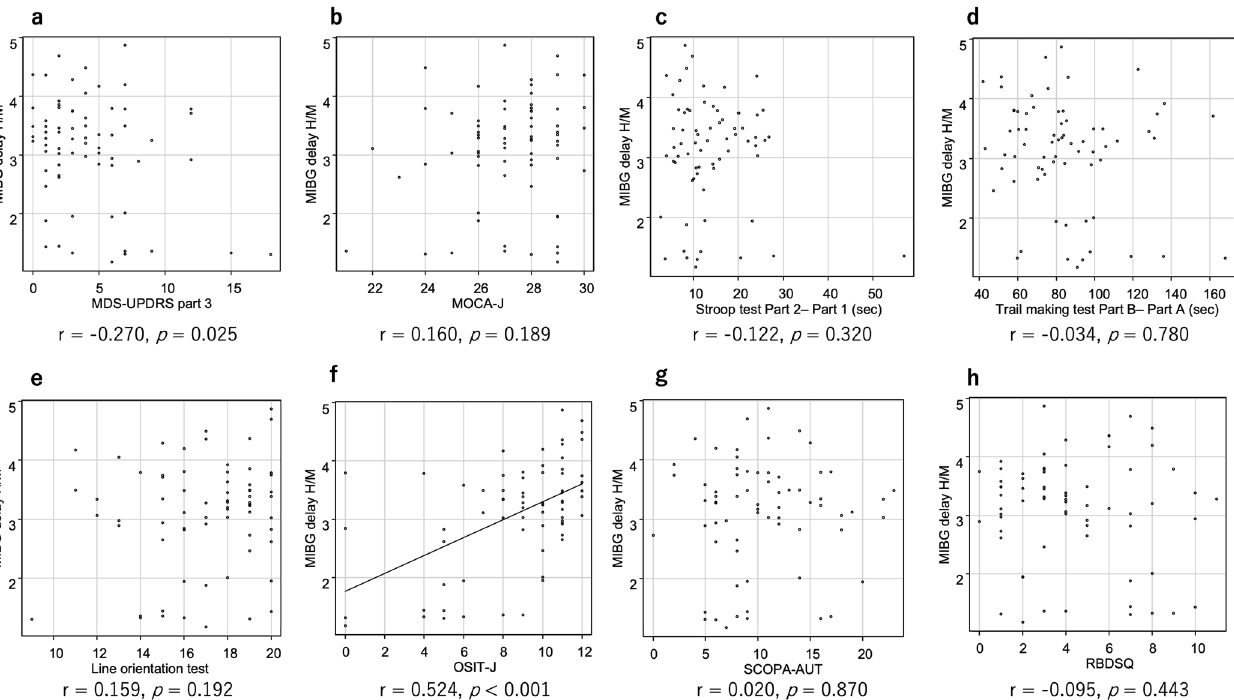
Fig. 4 The correlation between delayed MIBG H/M and clinical indices in the high-risk subjects. Pearson ’ s correlation test comparing the delayed MIBG H/M ratio and motor ( a ) and cognitive ( b – e ) functions as well as non-motor symptoms ( f – h ) in the participants. MIBG metaiodobenzylguanidine, MDS-UPDRS Movement Disorder Society-sponsored revision of the Uni fi ed Parkinson ’ s Disease Rating Scale, MoCA-J the Japanese version of the Montreal Cognitive Assessment, OSIT-J the odor stick identi fi cation test for Japanese, SCOPA-AUT the Japanese version of the Scale for Outcomes in Parkinson ’ s disease for Autonomic Symptoms; RBDSQ RBD screening